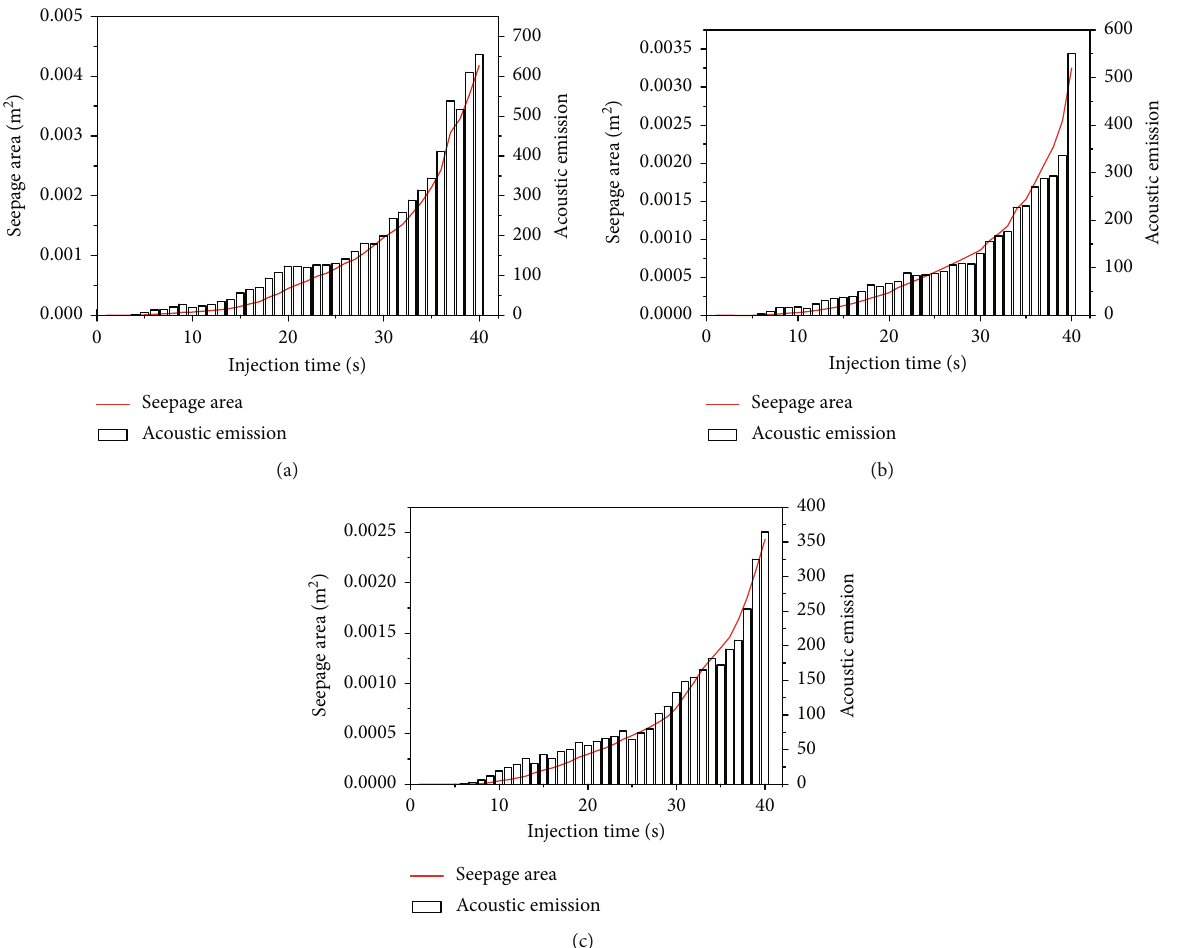
Figure 13: The development of seepage area and acoustic emission with di ff erent levels of sti ff ness of bedding planes: (a) E E 1 / E 2 = 0 : 4 , and (c) E 1 / E 2 = 0 : 8